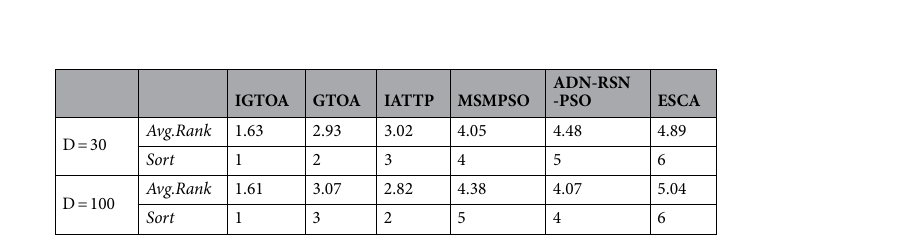
Table 8. The Friedman detection results for each